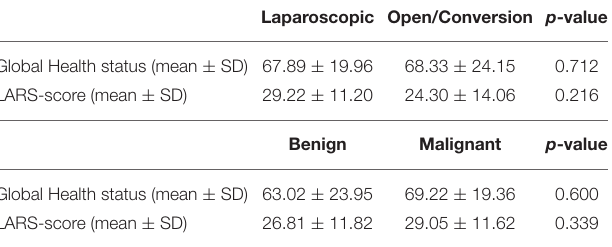
TABLE 3 | Global health status and LARS-Score according to potential influencing factors.